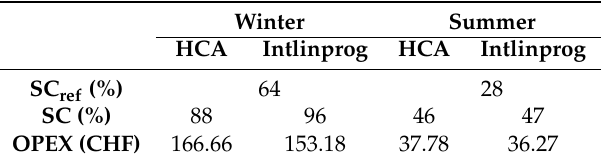
Table 4. The system OPEX and self-consumption rate (SC) achieved when using the HCA and intlinprog solvers in winter and summer simulations. ( SC ref ) denotes the self-consumption rate considering a reference case in which the entire HP load is met only by importing grid